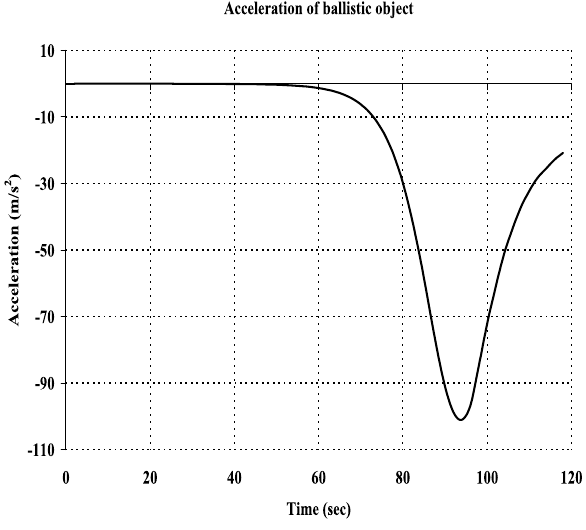
Fig. 4 Truth and estimate of RSCQKF for target position